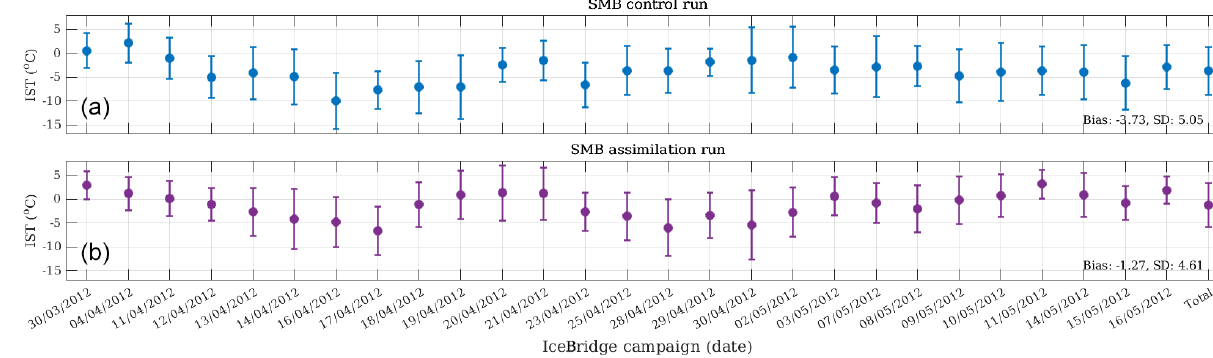
Figure 12. Mean bias (dots) and standard deviation (bars) for the control simulation (a) and the one using the assimilation of the L4 IST (b) against the IceBridge flight campaigns.